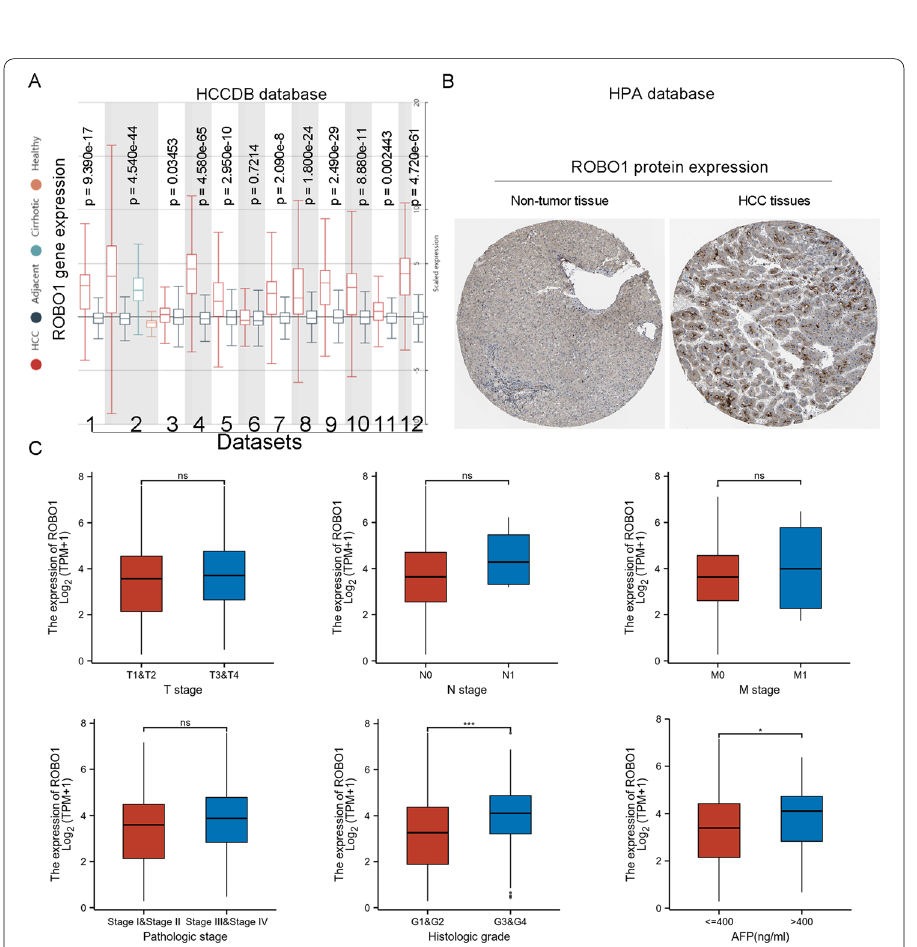
Fig. 3 Further validation of ROBO1 expression in HCC. HCCDB database was utilized to analyse ROBO1 gene expression ( A ). HPA database revealed prominent positive staining of ROBO1 ( B ). The association between ROBO1 expression and clinical parameters in HCC ( C